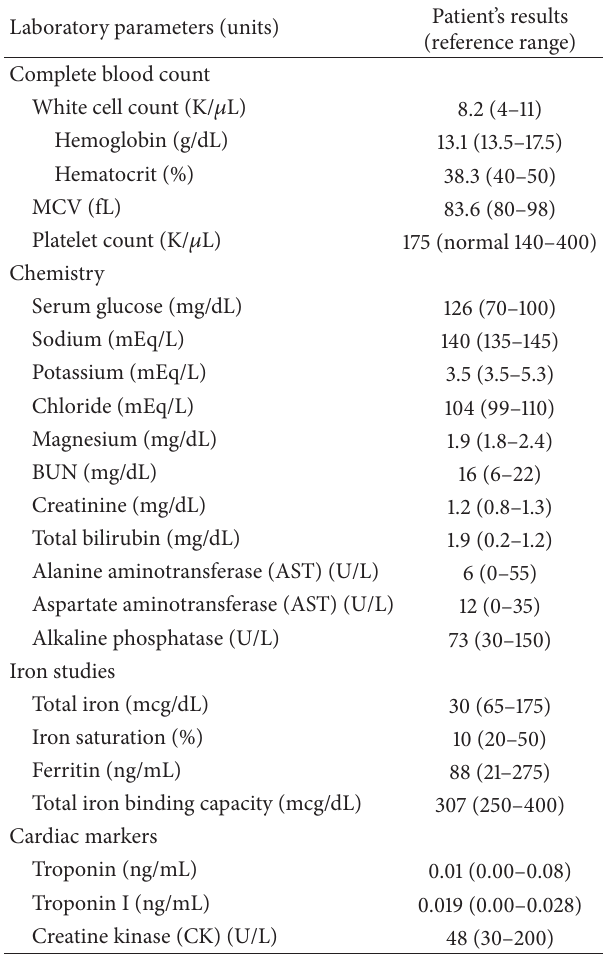
Table 1: Laboratory and biochemical